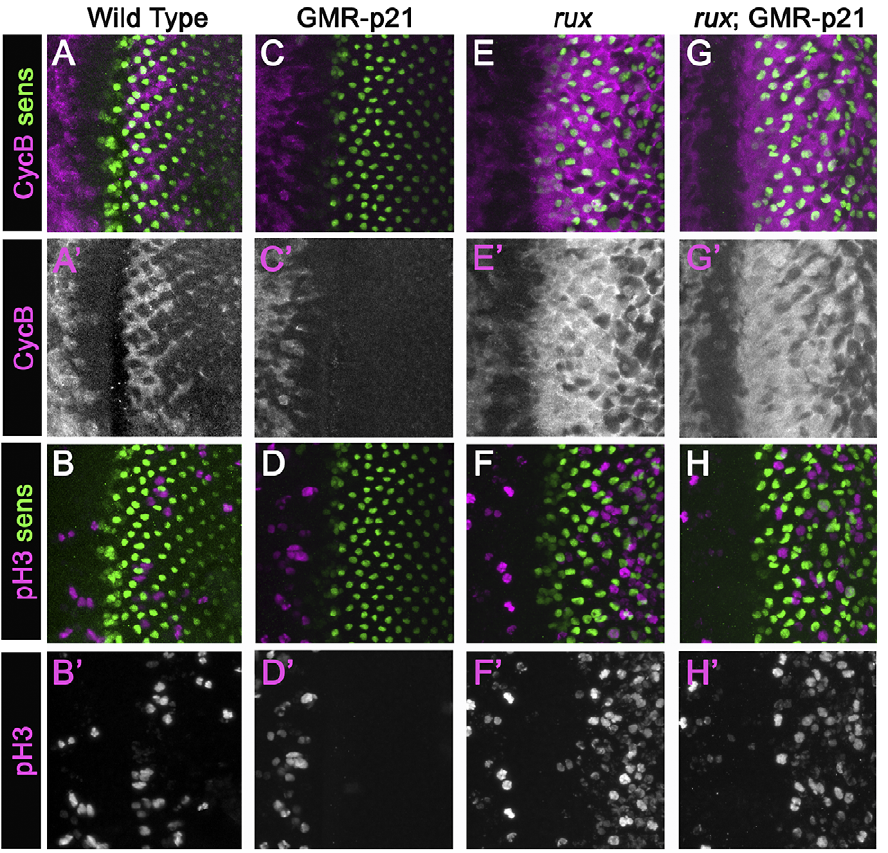
Figure 2. Mitotic activity in rux mutants is not affected by p21. Eye discs from different genotypes labeled with Sens (green) and Cyclin B (A,C,G,E) or H3p (B,D,F,H) in magenta. (A)(B) Wild type eye discs exhibit the pattern of cells entering the SMW. (C)(D) When p21 is expressed this blocks the Second Mitotic Wave. (E)(F) In rux , arrest ahead of the morphogenetic furrow is incomplete and truncated, and there is much more mitotic activity posterior to the furrow. (G,H). rux ; GMR-p21 eye discs are identical to rux (compare panels